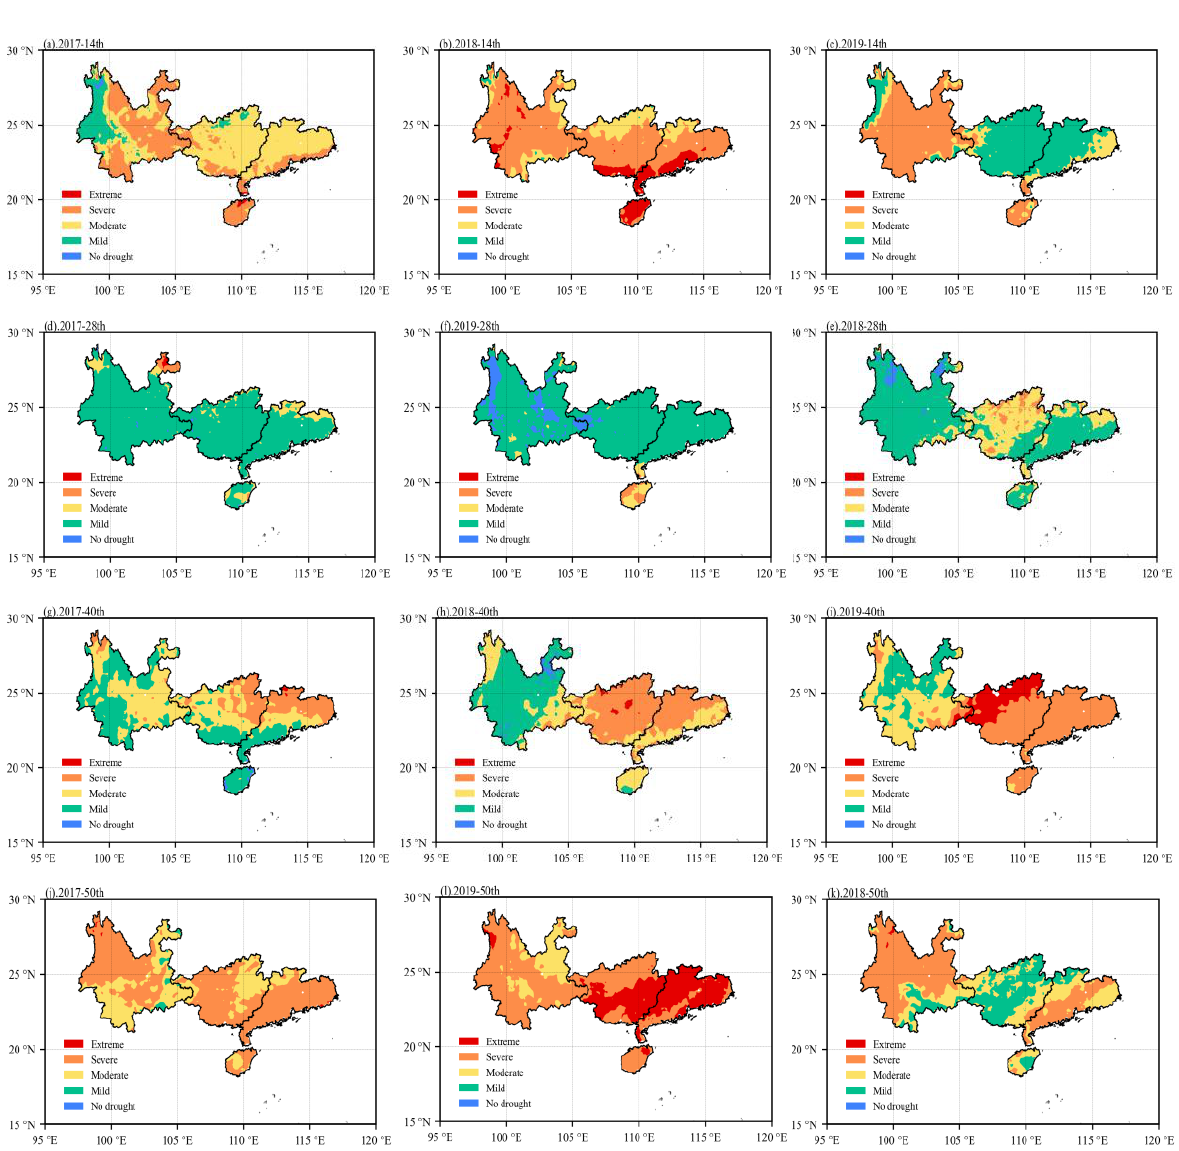
Figure 9. Spatial distribution of the weekly SWDI in the 14th ( a – c ), 28th ( d – f ), 40th ( g – i ), and 50th ( j – l ) weeks in the four southern provinces of China during 2017–2019.